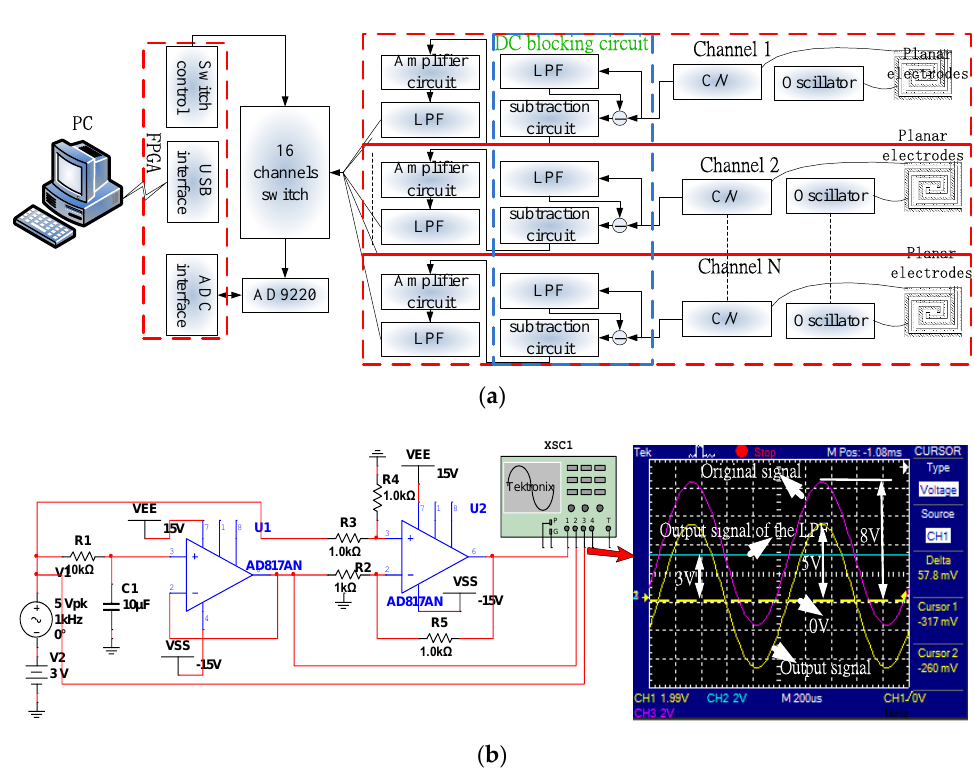
Figure 11. Input-output curve of the C/V circuit.